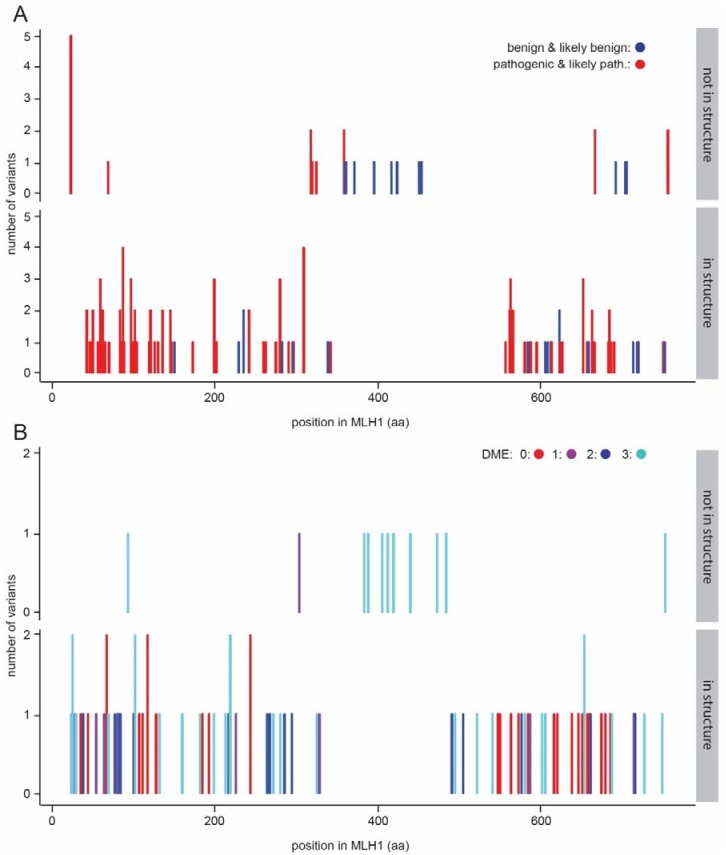
Variants within the central disordered region.(A) ClinVar benign and likely benign variants (blue) are found throughout the protein, while pathogenic and likely pathogenic variants (red) are enriched in the structured domains. (B) The variants previously tested for function (Takahashi et al., 2007) are distributed throughout the MLH1 protein. Similar to the observations from ClinVar, functional variants (DME score 3) are seen throughout the protein, while loss-of-function in multiple assays (DME scores.